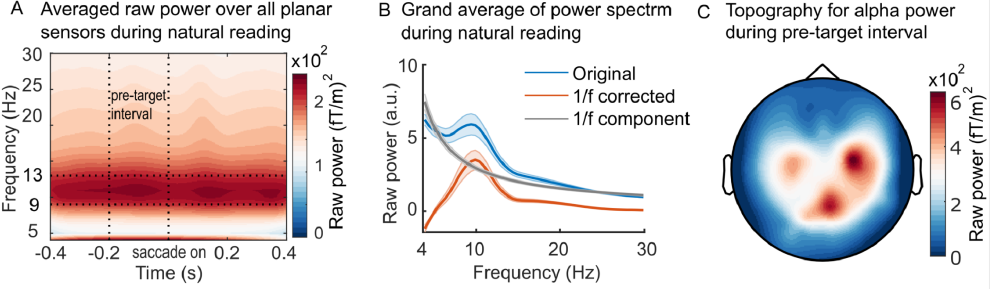
Fig 2. Raw time frequency representation during natural reading and the topography of alpha power. (A) Averaged power over all trials, all planar sensors, and all participants. The time-frequency representation of power was aligned with the saccade onset towards the target word. The vertical dashed lines indicate the start of the pre-target interval ( − 0.2 s) and the saccade onset towards the targets (0 s). The horizontal dashed lines indicate the 9–13 Hz alpha band. (B) The grand averaged power spectrum of the original data in (A), which was separated into the 1/f component (in grey) and the 1/f-correct components (in orange). The shaded areas indicate the standard error over participants ( n = 38). (C) Topography of the averaged alpha power during the pre-target fixation interval from Fig 2A. The data in panel (A) and (B) in the figure can be found in S1 Data.